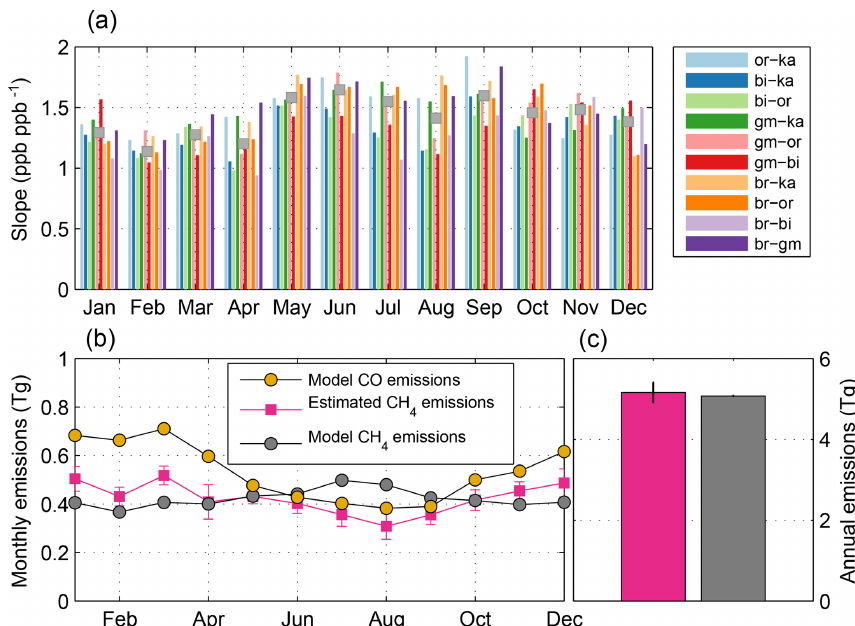
Figure 5. This figure shows the results from the modeling experiment using GEOS-Chem. Panel (a) shows the model (cid:49) X CH for each month and pair of stations (indicated by the colors). The median slopes for each month are overlaid with grey squares. Panel (b) shows the model carbon monoxide emissions (excluding VOC and methane oxidation) and the model methane emissions. The inferred methane emissions from our tracer–tracer slope method are plotted in pink squares. Panel (c) shows the annual methane emissions from the tracer–tracer slope method and the model.